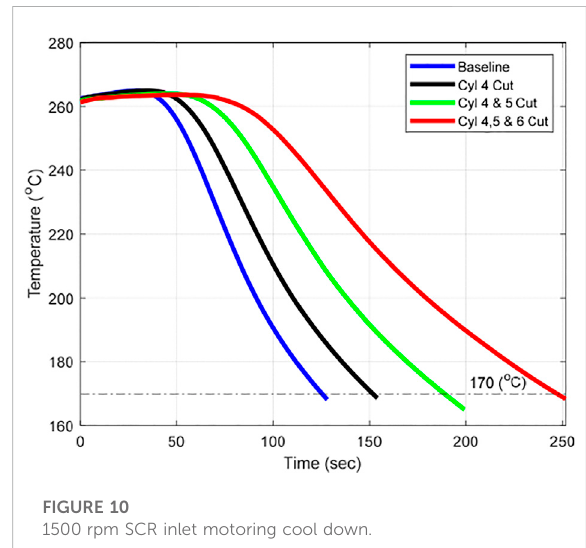
FIGURE 10 1500 rpm SCR inlet motoring cool